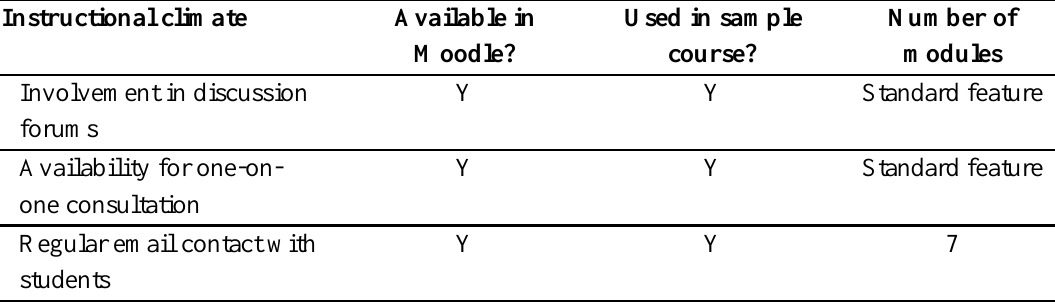
Availability of Moodle Modules Serving the Instructional Climate